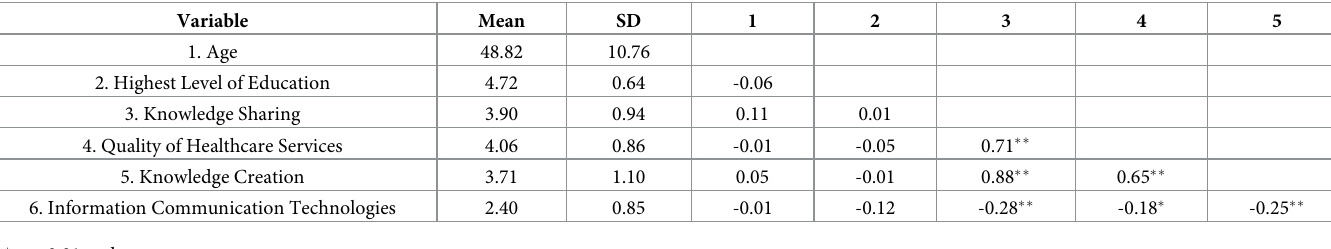
Table 2. Mean values, standard deviations and coefficient correlations (n =